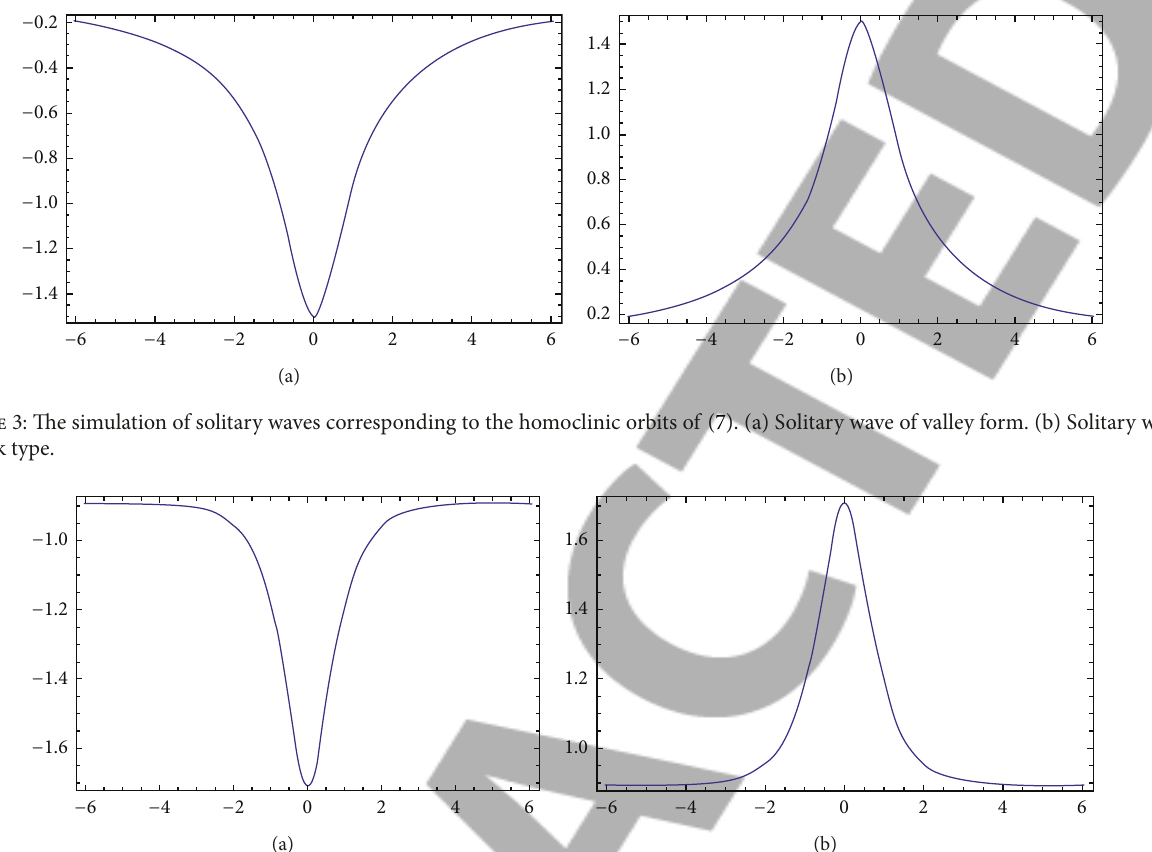
Figure 4: The simulation of the solitary waves corresponding to nilpotent homoclinic orbits of (7). (a) Solitary wave of valley form. (b) Solitary wave of peak